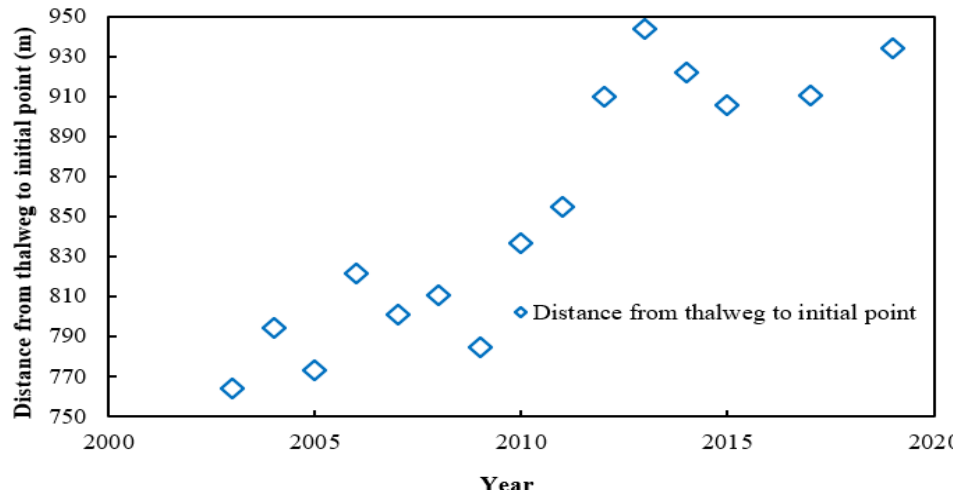
Figure 6. Variations in the Bankfull depth in the Wuhan reach.